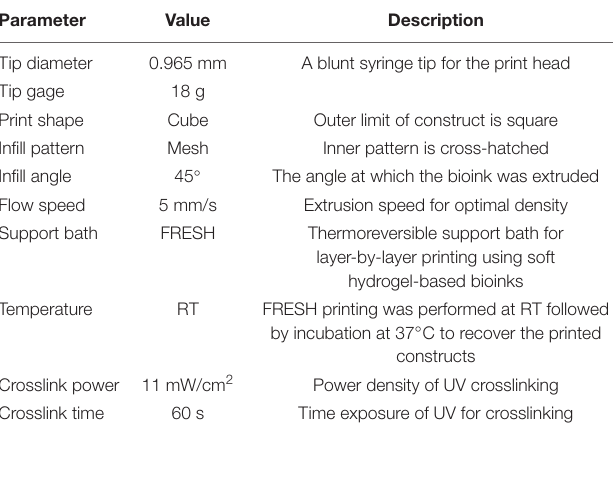
TABLE 1 | Parameters for 3D bioprinting of microfat-laden collagen